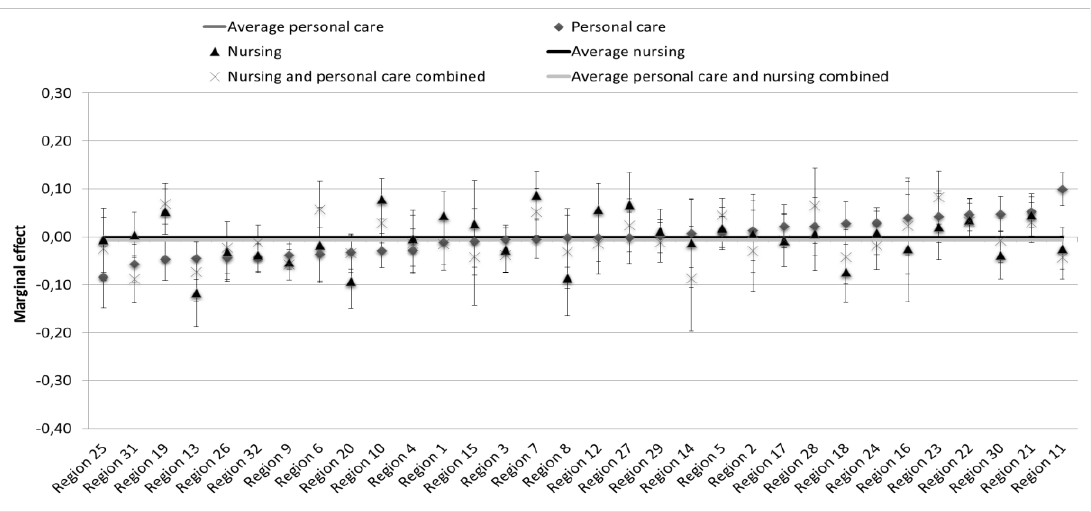
Figure A4: Variation in home care entitlements granted processed by CNAC 65-